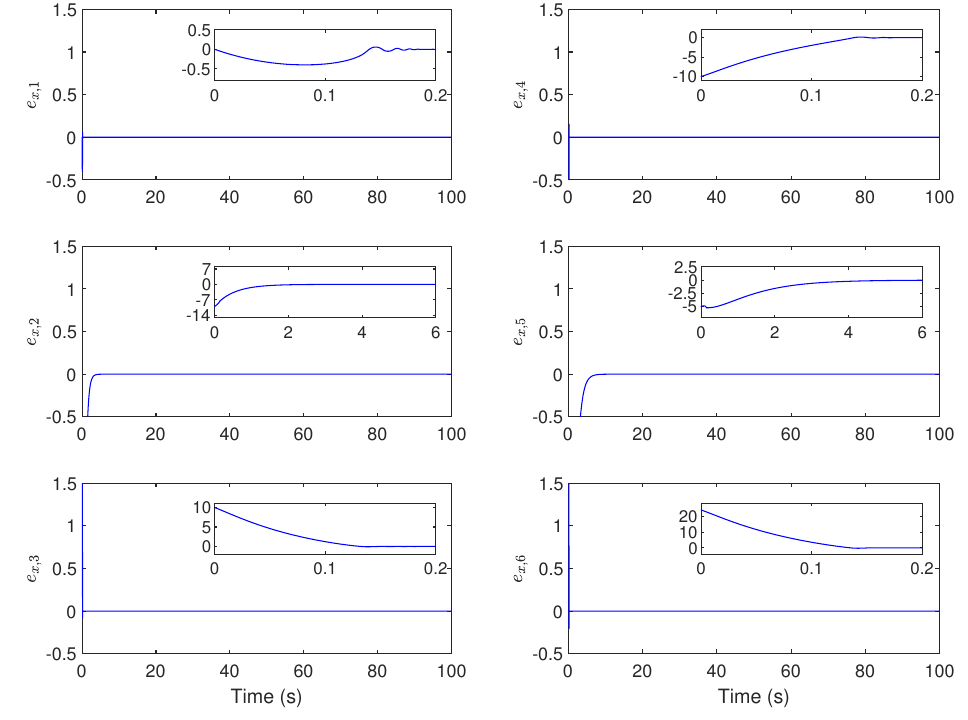
Figure 4. State estimation errors for the central SMO when u cc = 0.